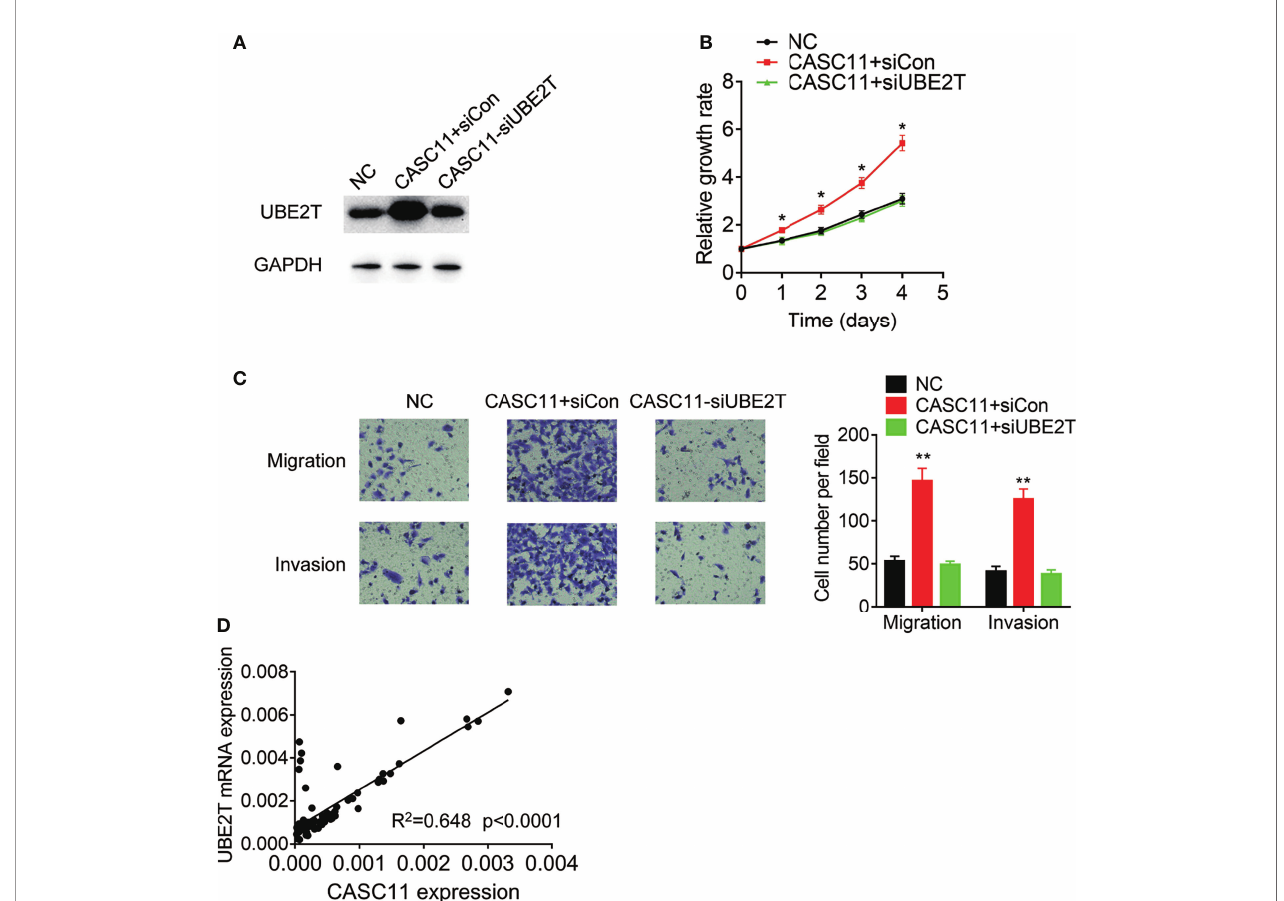
FIGURE 7 | CASC11 promotes malignant phenotypes of HCC cells via UBE2T. (A) The CASC11 overexpressing Huh7 cells were transfected with UBE2T siRNA. The protein level of UBE2T was detected using western blot. (B) The CASC11 overexpressing Huh7 cells were transfected with UBE2T siRNA. The cell proliferation